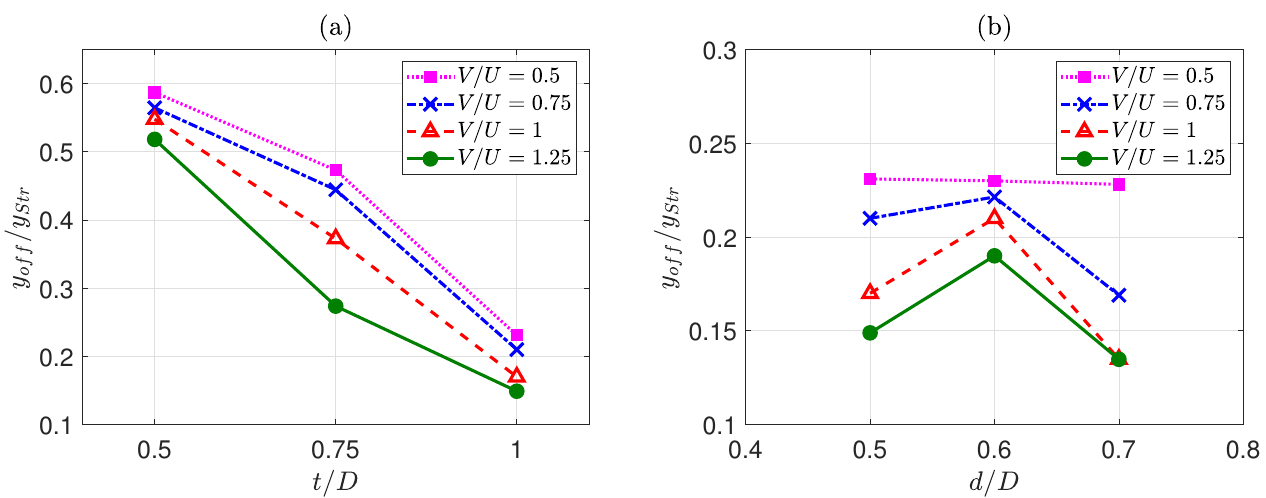
Figure 11. Variation of the normalised offset distance with changing the normalised process parameters when ( a ) d / D = 0.5, and ( b ) t / D =